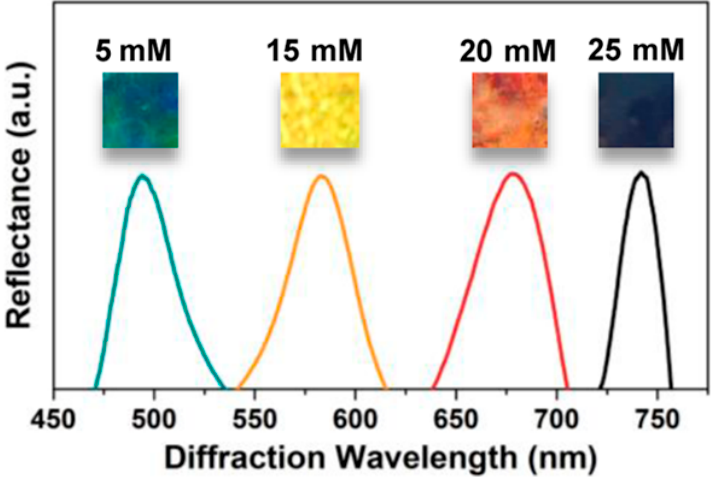
Figure 14. Red shift in peak optical reflectance of hydrogel-encapsulated CCAs with increasing concentration of immobilized negatively charged groups from phosphorylation of peptides (at pH 5.5). Reproduced with permission from [26].